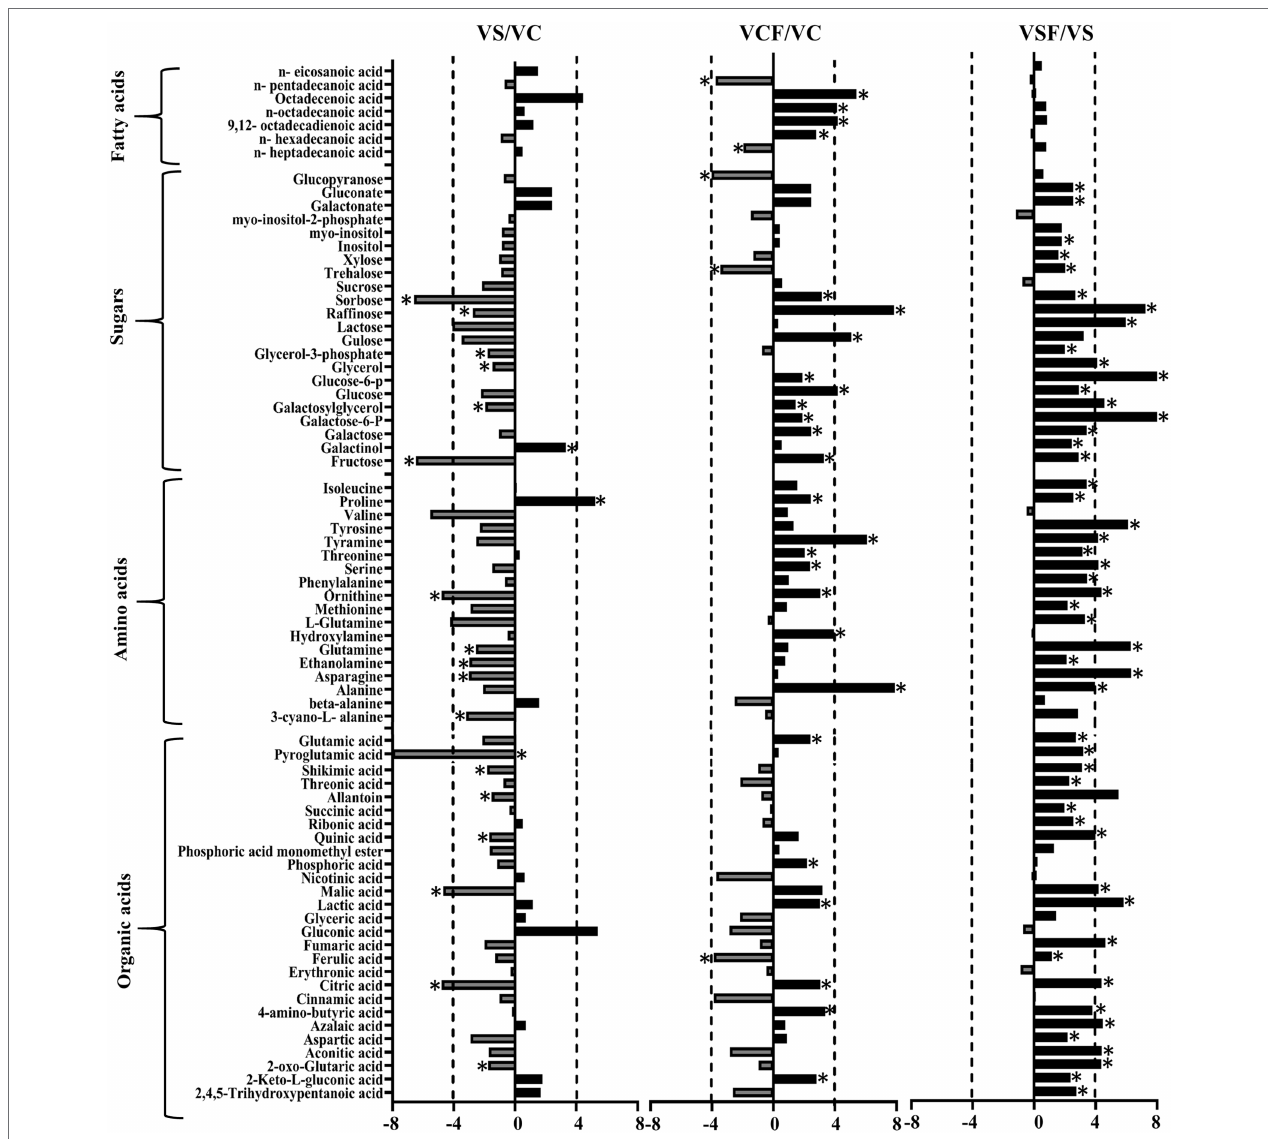
FIGURE 5 | The graphs represent salt grown vs. control grown ( VS /VC); control with fungus vs. control grown (VCF/VC); and salt with fungus vs. salt grown (VSF/ VS ) logarithmic ratios of representative sugars, organic acids, and amino acids in roots of barley cv. Vlamingh (V). An asterisk (*) indicates that the values are significantly different ( p < 0.05, FDR). A dashed line indicates a four-fold change